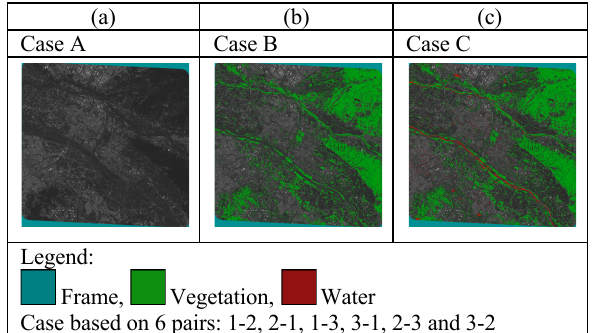
Figure 9. Case Study. Case A, frame. Case B, frame and vegetation. Case C, frame, vegetation and